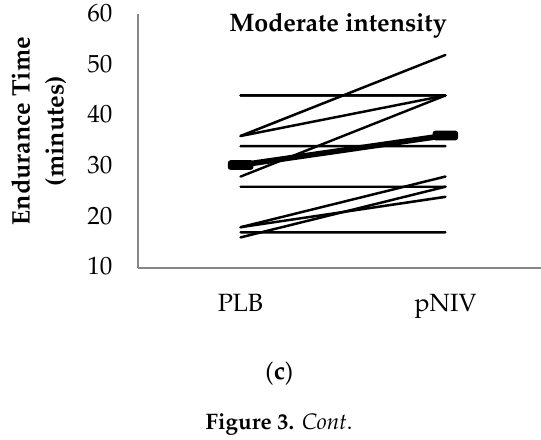
Figure 3. Exercise endurance time using pNIV (solid bars) and PLB (grey bars) during high ‐ and moderate ‐ intensity exercise protocols ( a ). Effect of pNIV on individual patient exercise endurance time during high ‐ intensity ( b ) and moderate ‐ intensity ( c ) exercise protocols. Solid lines indicate mean values.